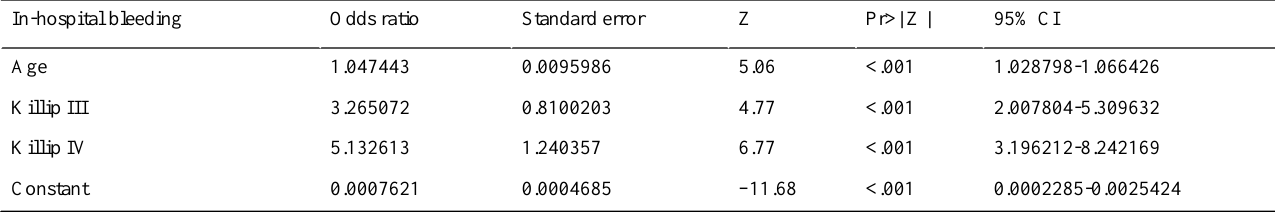
Table 2. Predictors of in-hospital bleeding obtained from multivariable logistic regression models (odds ratio) in the development data set.